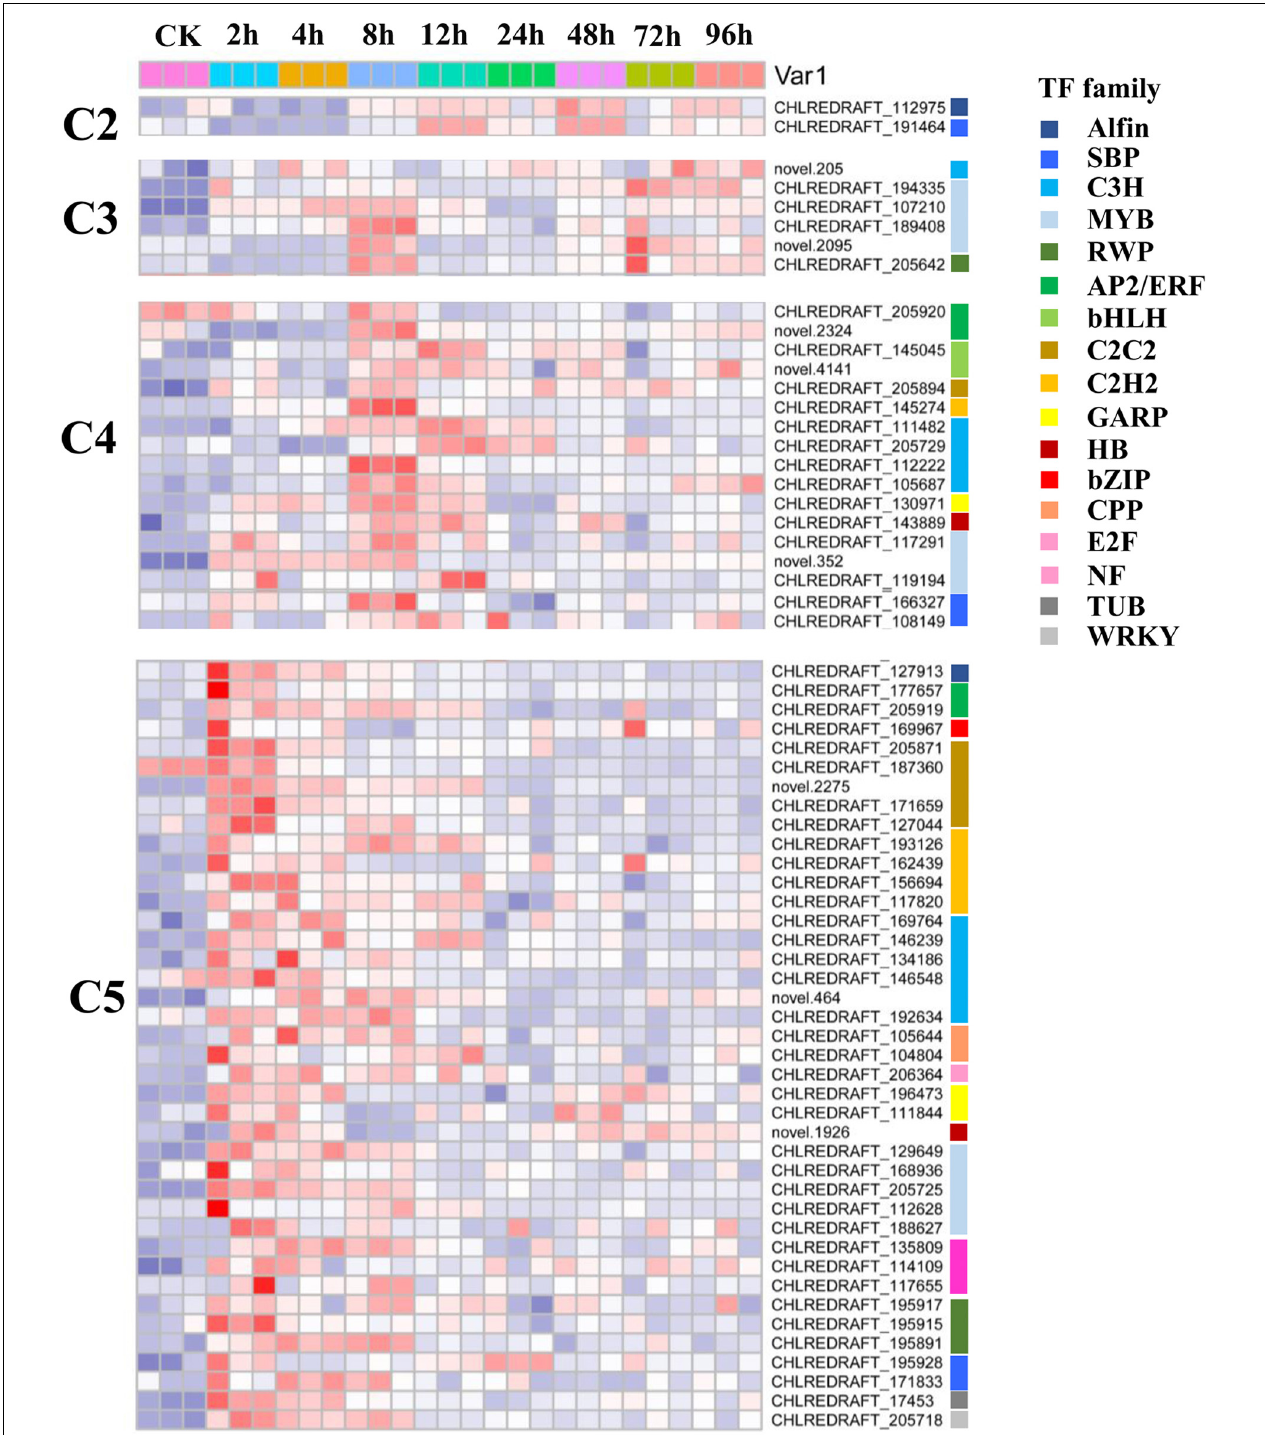
FIGURE 4 | Expression pattern of transcription factors (TFs) including in DEGs cluster C2, C3, C4, and C5 in eight time points samples.